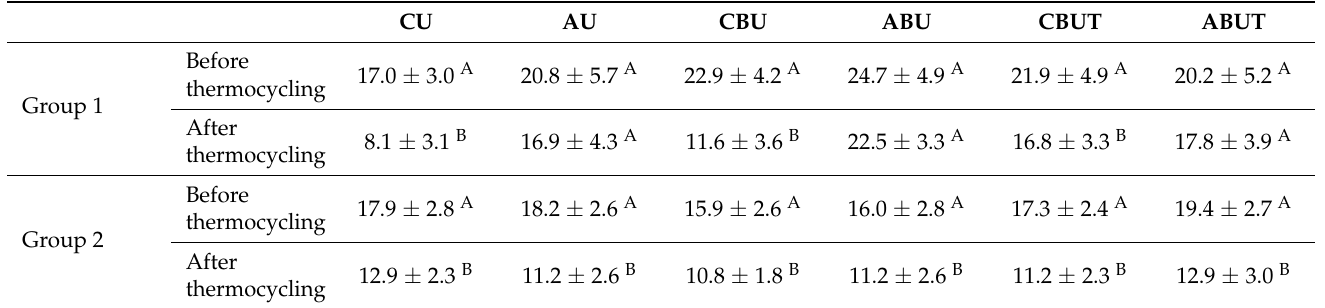
Figure 7. High-magnification (×2000) SEM images of both types of 3D printing resins for different surface treatments: ( a ) No surface treatment of Group 1; ( b ) APA of Group 1; ( c ) no surface treatment of Group 2; and ( d ) APA of Group 2. The red arrows indicate the deep, and wide porous surface. 3.3. Roughness The results of the Ra values according to surface treatments of the two types of 3D printing resins are presented in Table 4, and the representative 3D surface morphology images of each group are presented in Figure 8. Both resins presented significantly in- creased Ra values compared to those in the control group after APA treatment. In the control group, the Ra values between the two materials showed similar results, but in the APA group, Group 2 showed a significantly higher Ra value than Group 1.